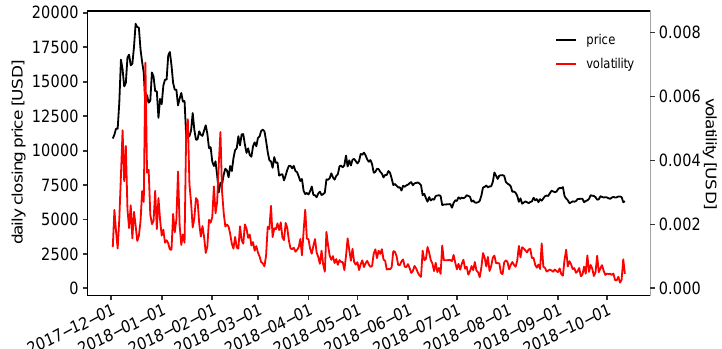
Figure 5. Daily closing prices and volatility. We plot the last available mid-price m ( t ) of each day in universal coordinated time and the realized volatility rv ( t − 1day, t ,1min ) for the respective day. Table 6. Descriptive return statistics. This table lists statistical properties of logarithmic mid-price returns r mid ( t , ∆ t ) on different time scales ∆ t , in units of 1bp (where applicable). ∆ t = 1min ∆ t = 1h ∆ t = 1day min − 363.0070 −